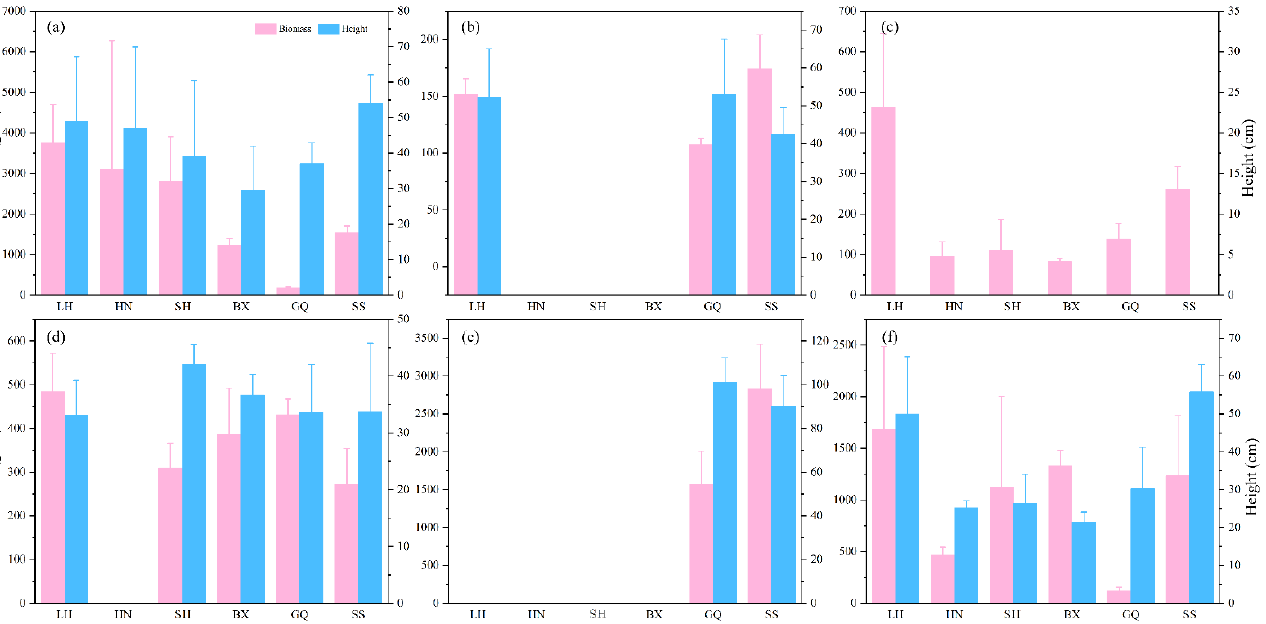
Table 3. The organic carbon content of seaweed species in the Ma ’ an Archipelago. Species Ulva pertusa Content The organic carbon content of seaweed was calculated by dry weight.